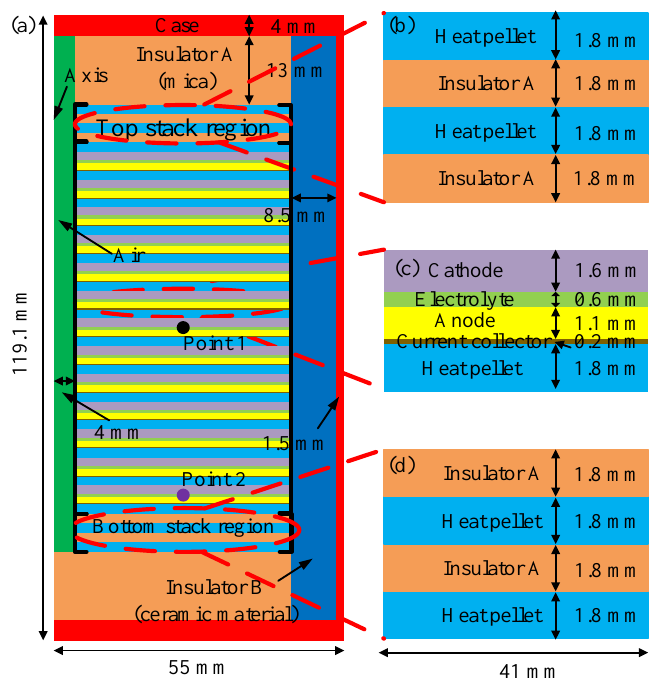
Figure 1. Schematic of ( a ) 13-stack thermal battery module, ( b ) top stack region, ( c ) unit cell and heat pellet, and ( d ) bottom stack region.